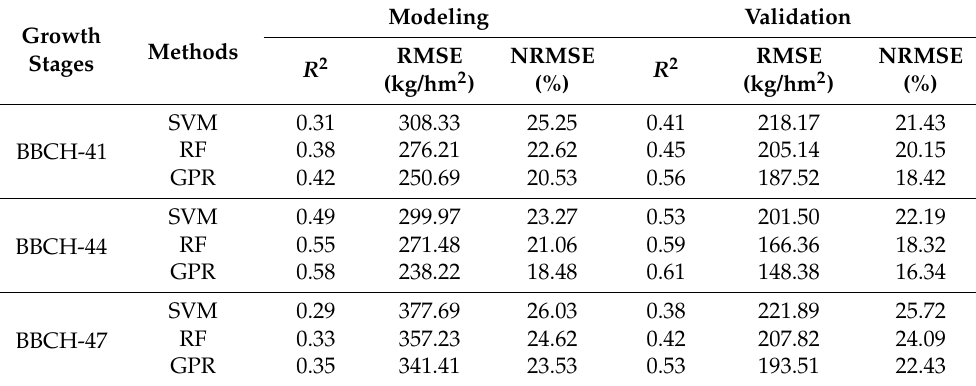
Table 4. Potato AGB estimates based on selected COS features using machine-learning methods for different growth stages.